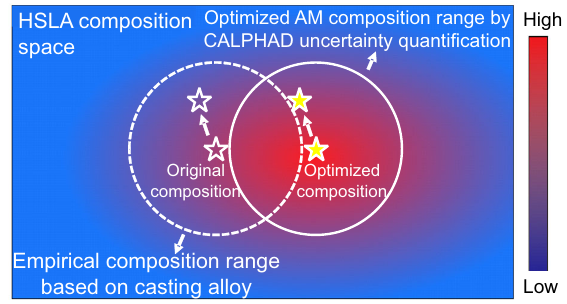
Fig. 9 Conceptual graphic illustrating the improvement of composition with uncertainty after ICME optimization. The color bar indicates the satisfaction of the powder composition, i.e., powder quality, with the potential to match the requirements of the design